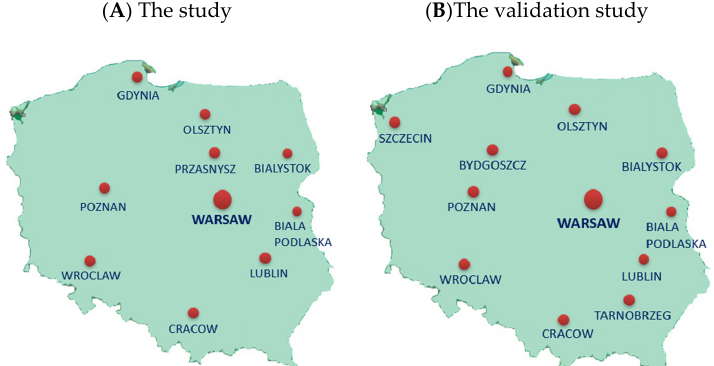
Figure 1. The location of academic centers involved in the study ( A ) or the validation study ( B ). A :